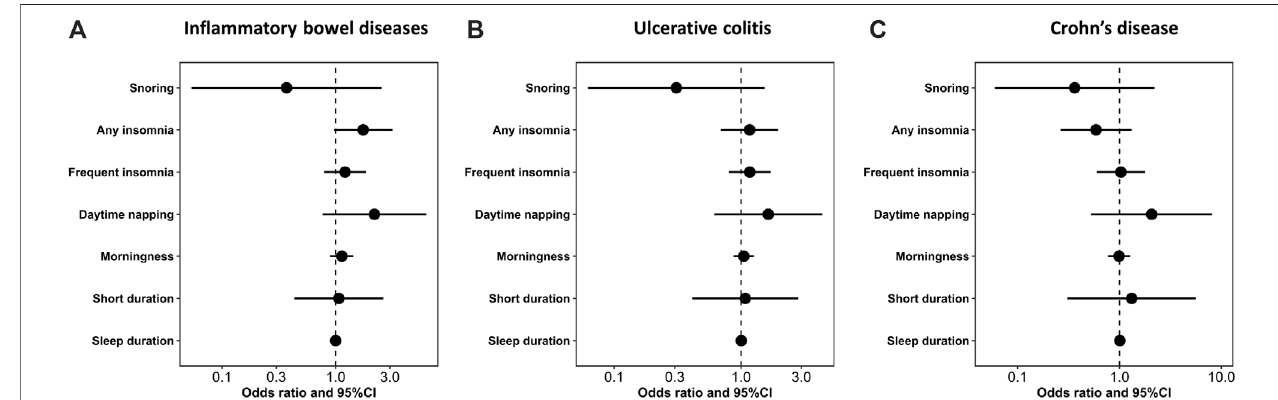
FIGURE 4| The size of the causal effect ofdifferential sleep traits on IBD. Abbreviations: 95%CI, 95% con fi dence interval. Annotation: The forest plots showed the sizeofthecausaleffectofdifferentialsleeptraitsonIBD.Thedotswerethepooledeffects — measuredbyoddsratio — ofthesleeptraits,andthehorizontallineswerethe corresponding 95%CIs. When the 95%CIs contained the null value (odd ratio (cid:1) 1), there was no causal effect of sleep traits on